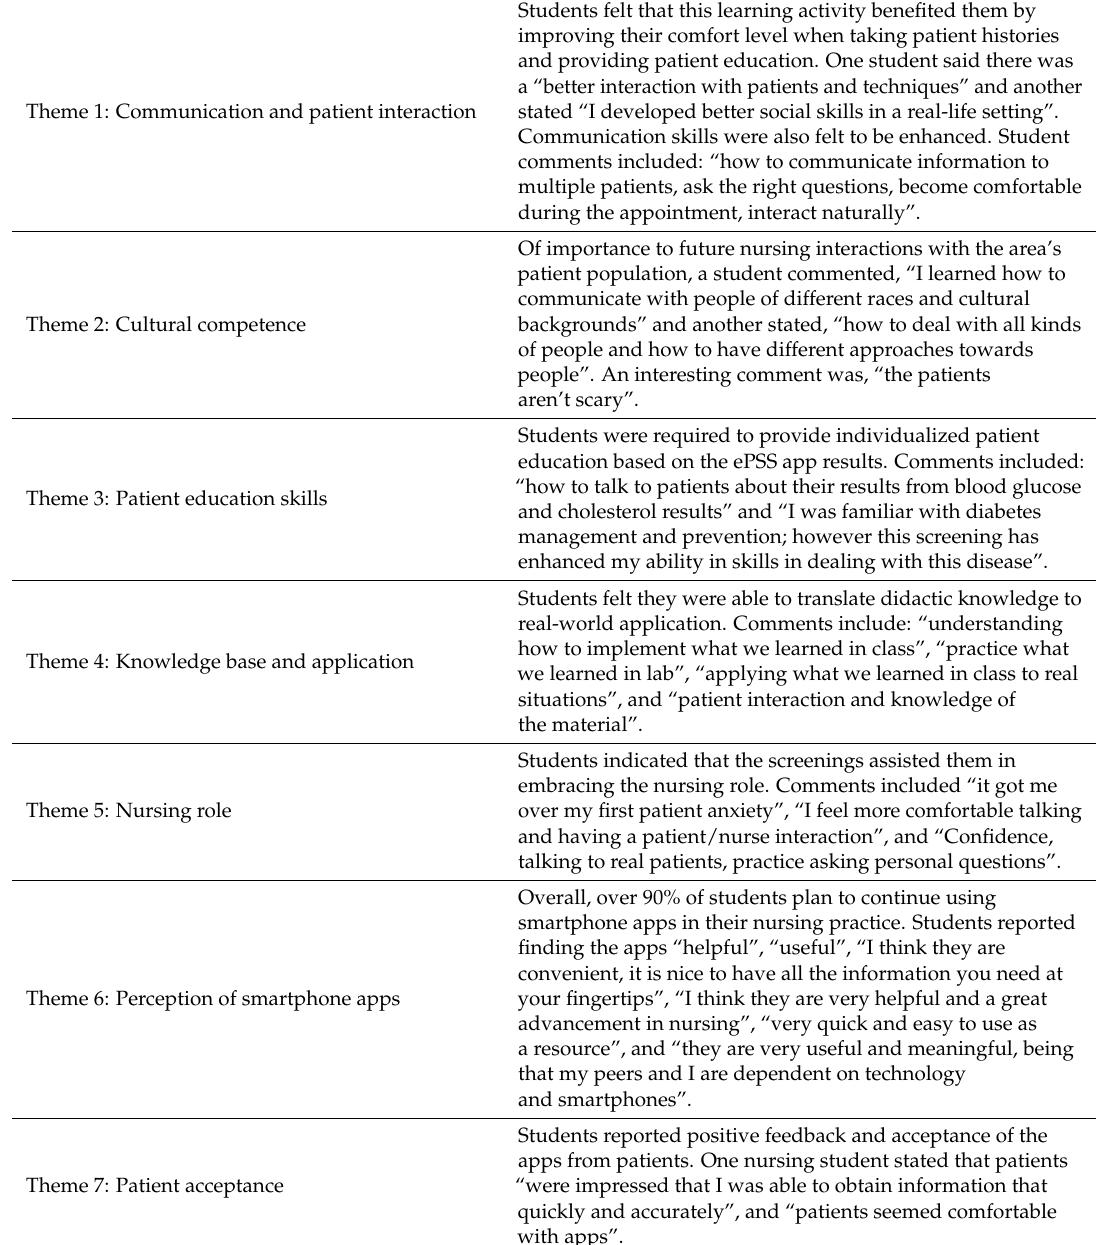
Table 3. Survey Results: Themes and